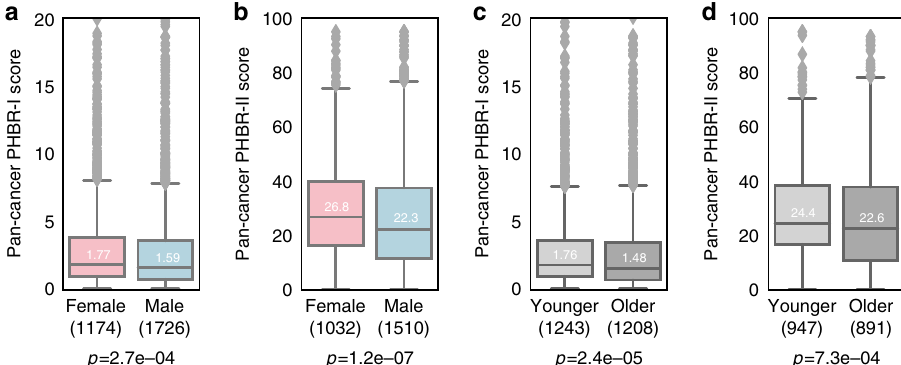
Fig. 1 Sex- and age-speci fi c MHC presentation of observed, RNA-expressed driver mutations. a , b Box plots denoting the distribution of ( a ) PHBR-I and ( b ) PHBR-II scores for expressed driver mutations in female and male pan-cancer patients. c , d Box plots denoting the distribution of ( c ) PHBR-I and ( d ) PHBR-II scores for expressed driver mutations in younger and older pan-cancer patients. P values were calculated using the one-tailed Mann – Whitney U test. Median values are shown in each boxplot. All box plots include the median line, the box denotes the interquartile range (IQR), whiskers denote the rest of the data distribution and outliers are denoted by points greater than ±1.5 × IQR. The following effect sizes were calculated using Cliff ’ s d: ( a ) r = − 0.0654, ( b ) − 0.104, ( c ) − 0.081, ( d ) −